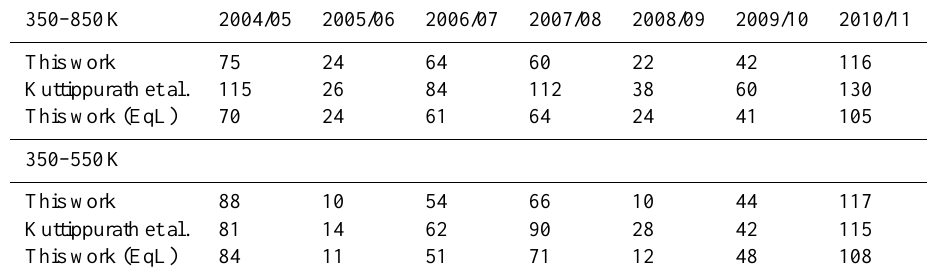
Table 2. Comparison of lower stratospheric column ozone loss estimates with those from Kuttippurath et al. (2010), with Kuttippurath et al. (2012) used for 2010/11. All losses are quoted in Dobson Units